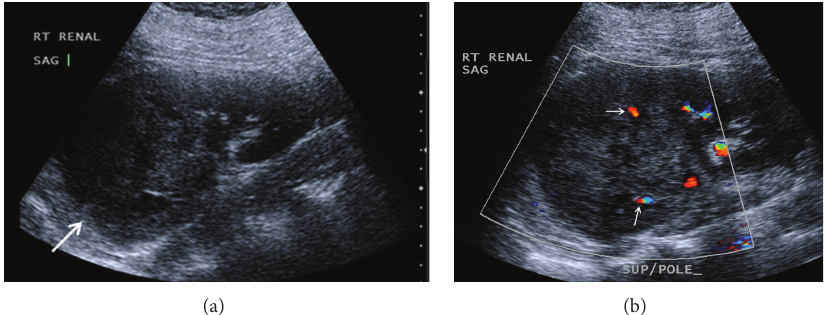
Figure 1: (a) Sagittal ultrasound image of the right kidney shows a large mass replacing the upper pole of the right kidney (arrow). The echotexture is similar to renal parenchyma with mild internal heterogeneity and a few cystic spaces. (b) Sagittal ultrasound image with Doppler shows internal vascularity (arrows) within the large mass replacing the superior pole of the right kidney.